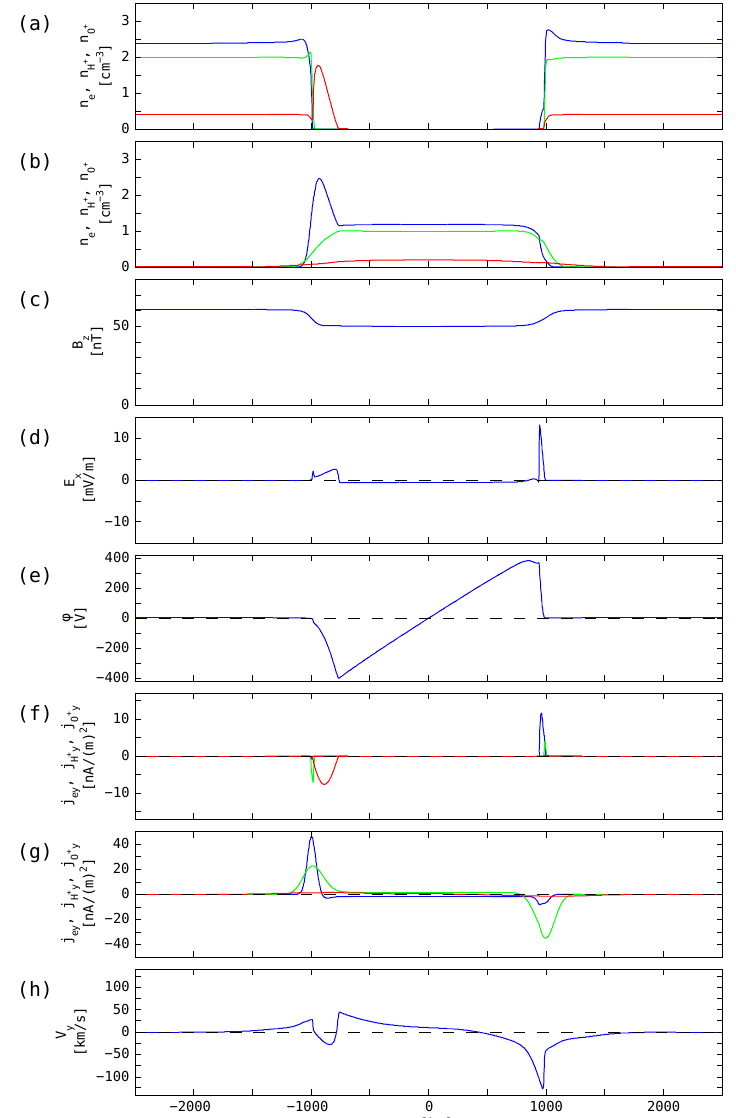
Fig. 7. Plasma and field structure of a 2000km-wide e − -H + -O + plasma slab embedded in a uniform background. The plasma parameters are given in Table 1. There is a cross-field flow V 0 y = 10kms − 1 at the slab centre. The electric potential boundary conditions are φ( ±∞ ) = 0V. The figure format is the same as in Fig.